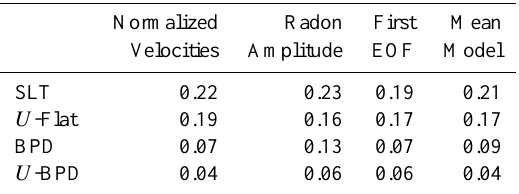
Table 2. The root mean square error of the theoretical profiles com- pared to each model profile and the mean model